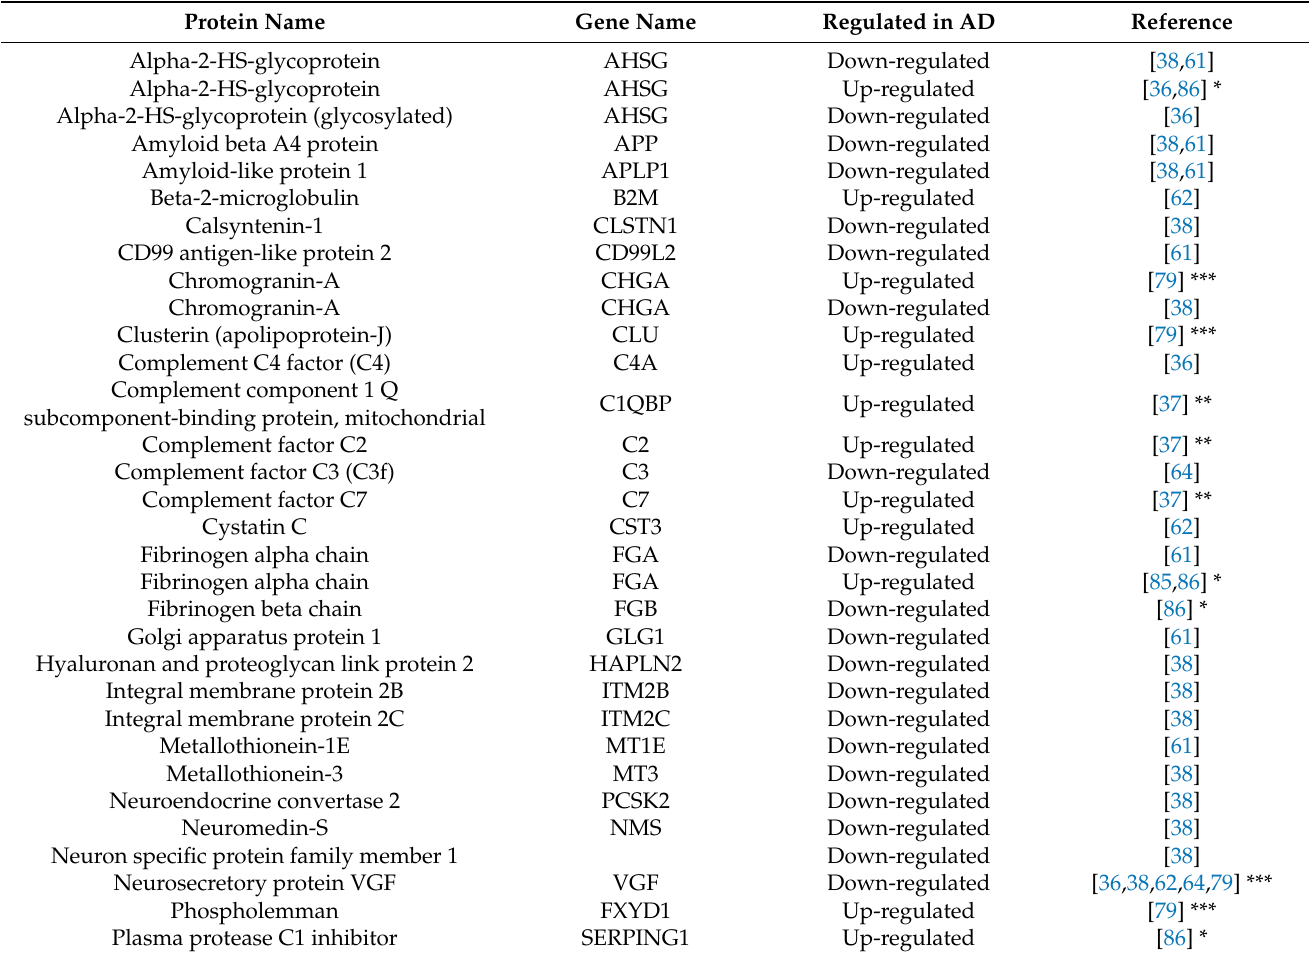
Table 1. Precursor proteins of peptides reported to be regulated in